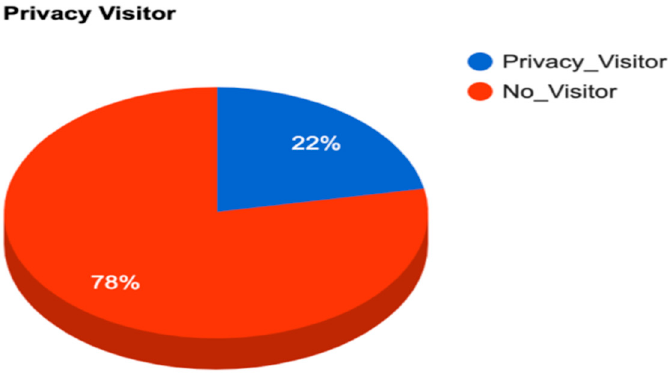
Figure 10. Overall privacy policy visitors. To test whether education had any relationship with how people handled their privacy, specifically the privacy of the content/data on their smartphones, the country-wise literacy rates data were obtained from [16]. These data were then augmented with information, such as country-wise Android app downloads and country-wise count of Android apps’ privacy page access data from our experiments. The list was then sorted based on the number of privacy page accesses country-wise to choose the sample data. Sample data are shown in Table 1, and the full data are shown in Appendix A.